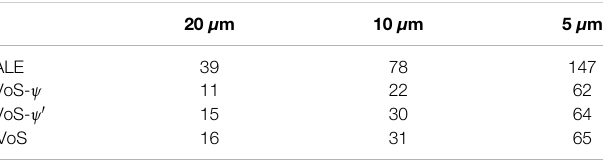
TABLE 2 | CPU time [min] obtained with the ALE, VoS- ψ , VoS- ψ ’ and iVoS methods at various mesh resolutions during dissolution of a calcite post by acid injection.